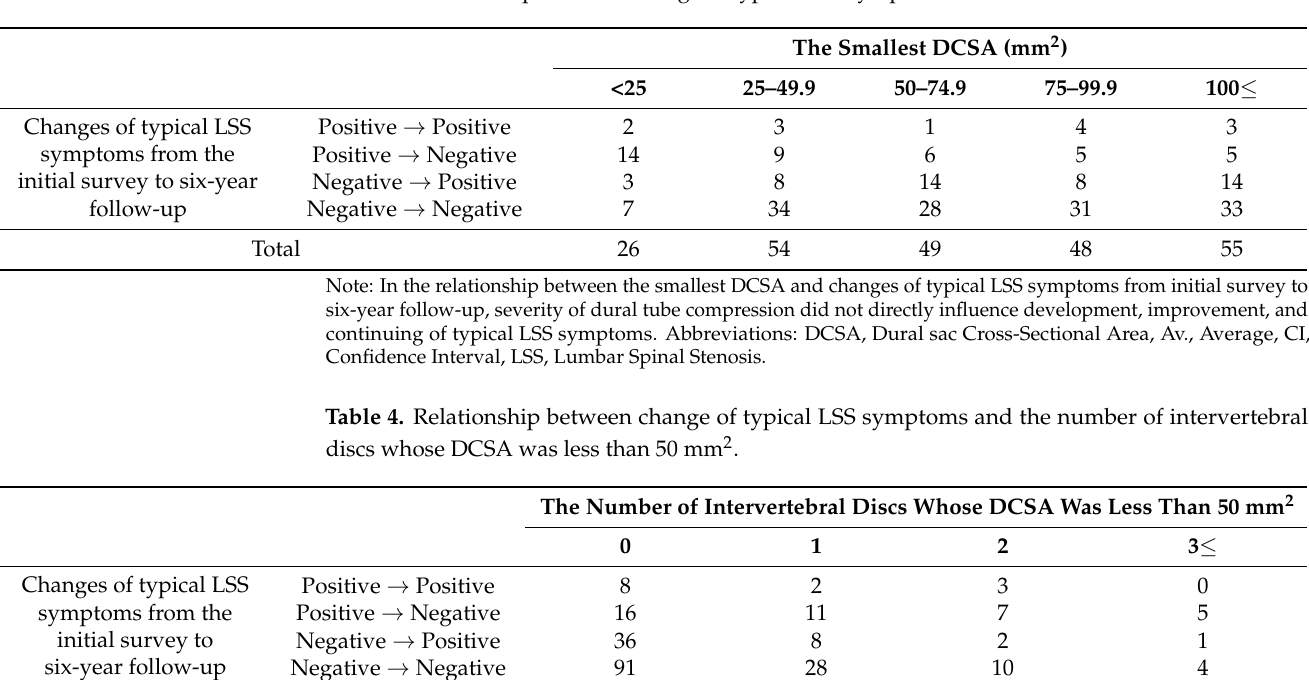
Table 3. Relationship between change of typical LSS symptoms and the smallest DCSA.